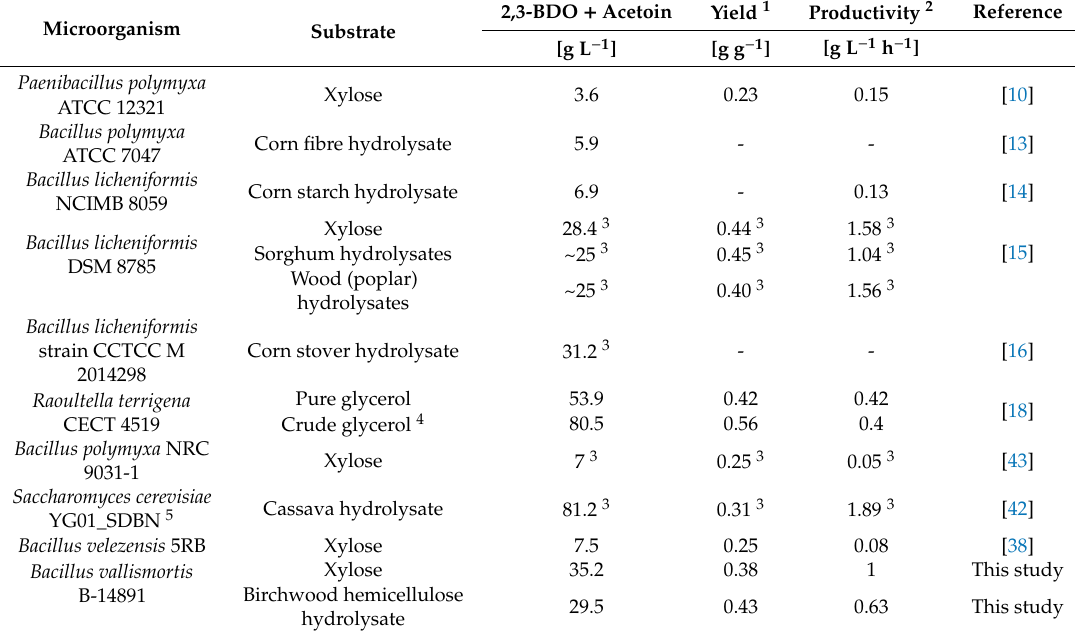
Table 2. Literature data of 2,3-BDO + acetoin production, yield and productivity from low cost substrates, industrial wastes as renewable carbon source during batch cultivation using risk class 1